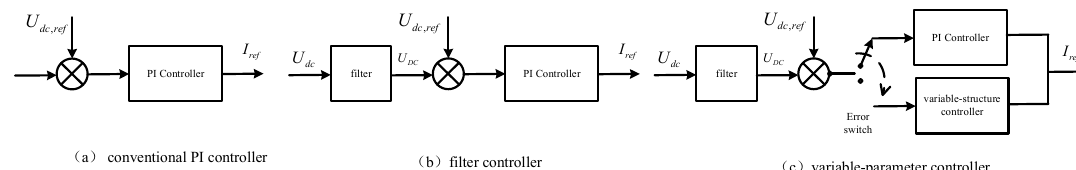
Figure 32. Block diagram of DC outer loop control.